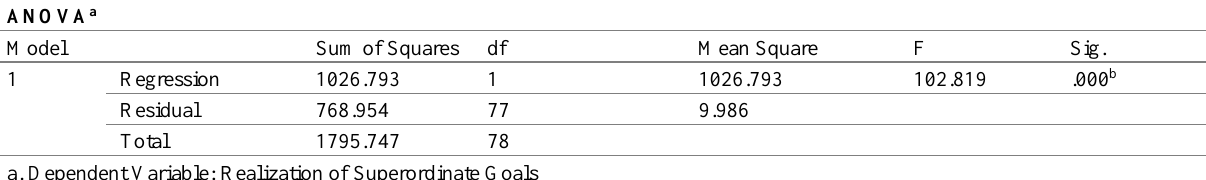
Table 7: Analysis of Variance